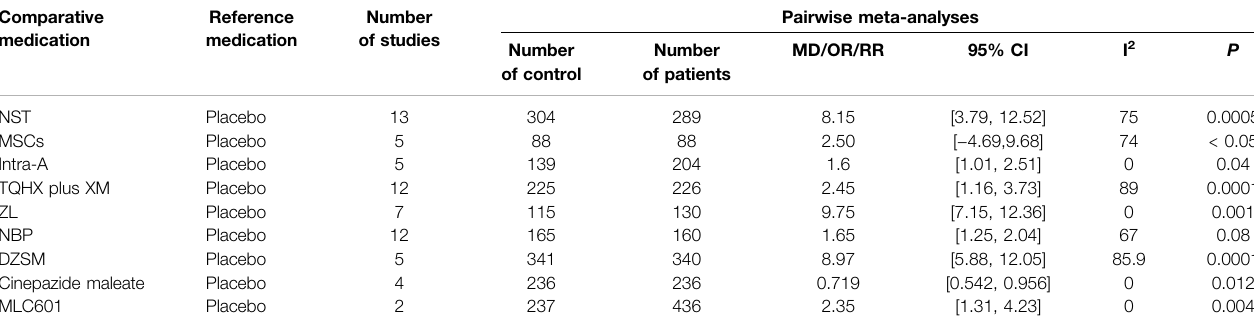
TABLE 5 | Results of pairwise meta-analyses for the BI score. Comparative medication